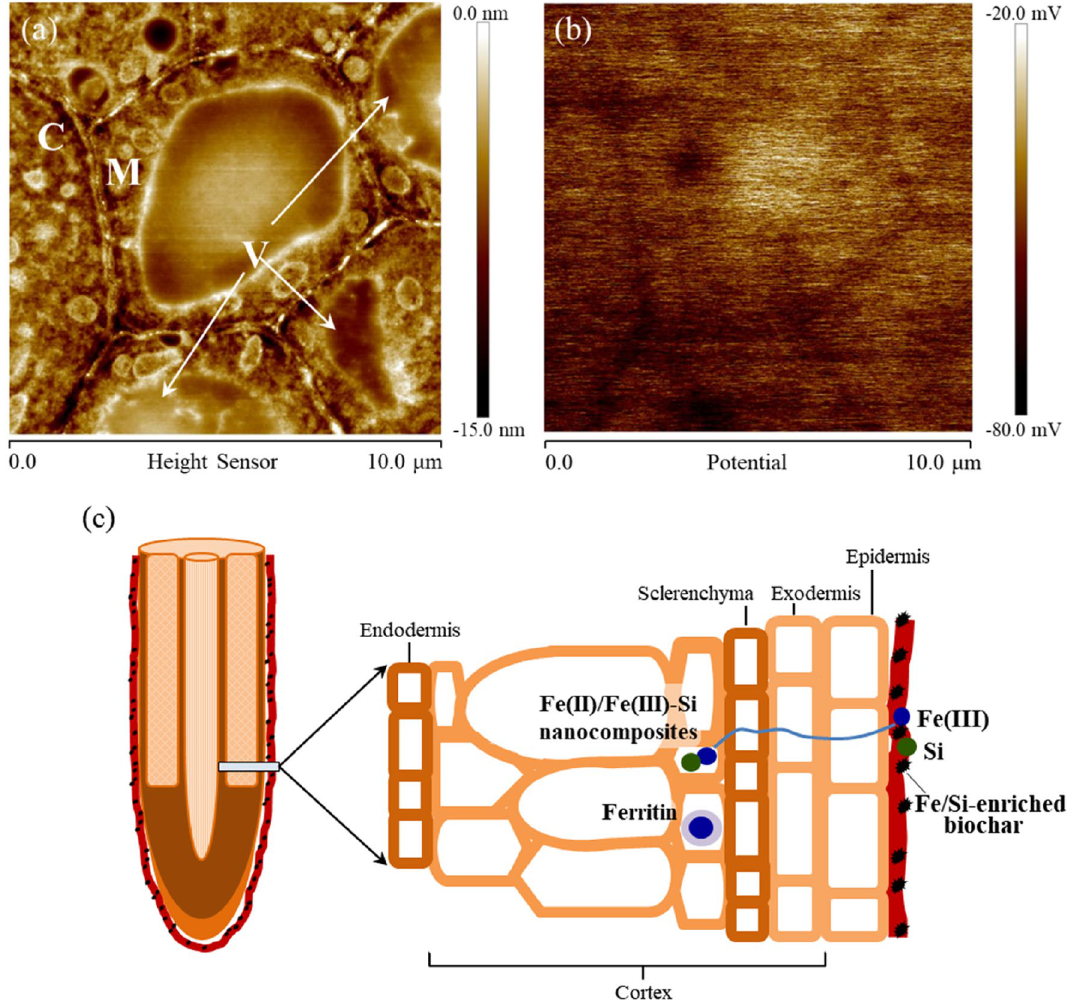
Figure 6. AFM images of a transverse section of a biochar-treated root embedded in resin. ( a ) Topographic image and ( b ) surface potential image. Internal cell structures including a vacuole (V), cytoplasm (C), and mitochondria (M) are apparent. ( c ) Schematic diagram of the formation of a complex Fe/Si phase in iron plaque on the root surface and iron-rich nanocomposites and ferritin within the rice root amended with Fe- and Si-enhanced